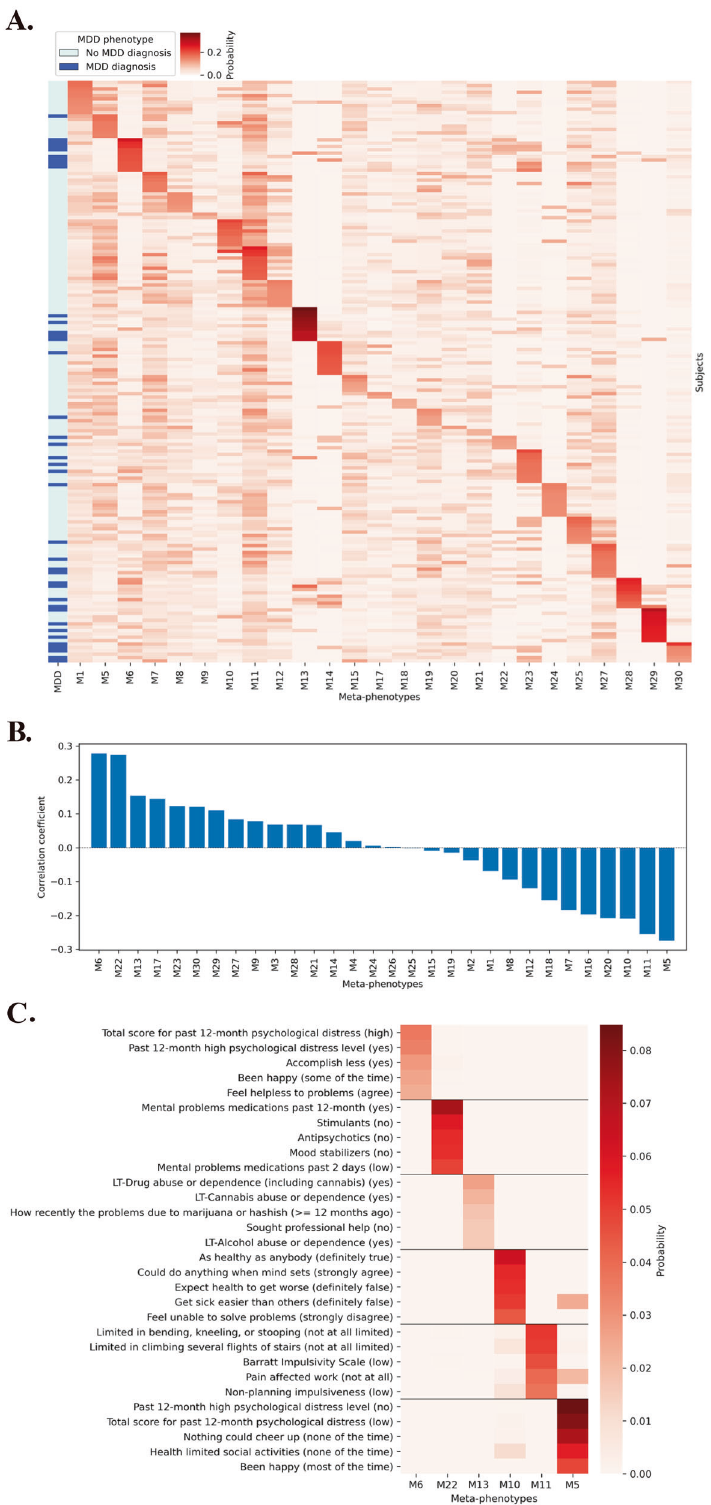
Fig. 2 Inferring meaningful MDD meta-phenotypes. A Inferring 30-topic mixture of the study cohort; ( B ) Linear correlation coef fi cients of the 30 meta-phenotypes; ( C ) Top MDD meta-phenotype